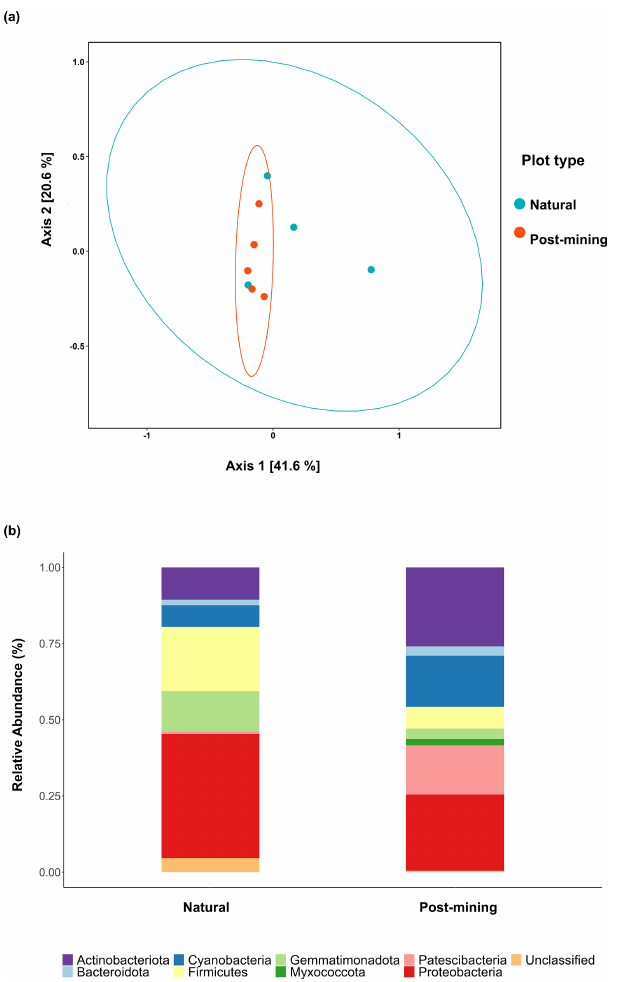
Figure 5. Composition of proliferated community. Top fig- ure (a) depicts a PCoA ordination of community composition based on weighted UniFrac similarity metric. Blue dots are natural sam- ples, and pink dots are post-mining samples. The ellipses represent 95% confidence intervals, the bottom figure (b) depicts a bar plot of phyla relative abundance (%) in natural and post-mining